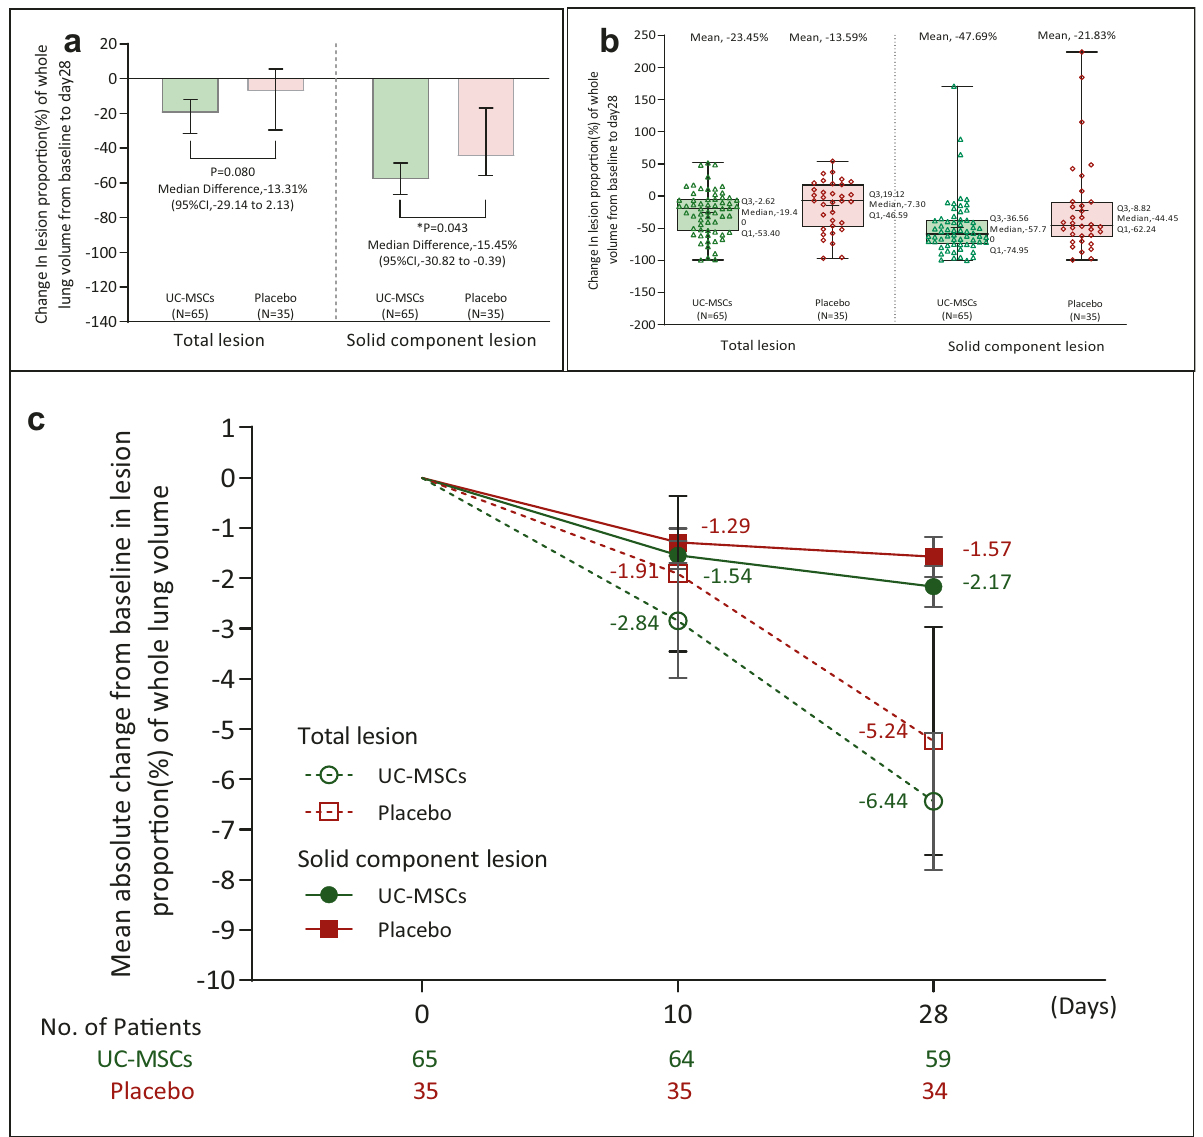
Fig. 2 The effect of human umbilical cord-mesenchymal stem cells (UC ‑ MSCs) on the lung damage in patients with severe COVID-19. UC ‑ MSCs decreased the proportions of total lung lesion volume and solid component lesion volume compared with the placebo at 28 days. a shows the between-group median difference in the change in total lesion proportion (%) and solid component lesion proportion (%) of the whole lung volume from baseline to day 28. I bars indicate the 95% CI described by Hahn and Meeker (1991). b shows box plots of the change in the total lesion proportion (%) and solid component lesion proportion (%) of the whole lung volume from baseline to day 28. Q1 denotes the fi rst quartile, and Q3 the third quartile. I bars indicate the minimum and maximum. c shows the mean absolute change from baseline in the total lesion proportion (%) and solid component lesion proportion (%) of the whole lung volume. I bars indicate the standard